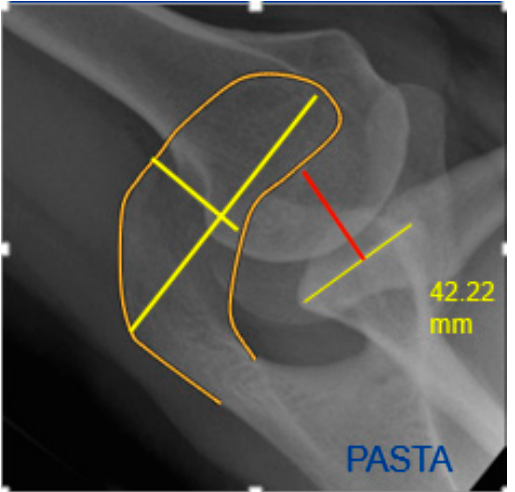
Figure 5. Right axillary shoulder radiograph: medial border offset (red), length/width of the acromion (bright yellow).